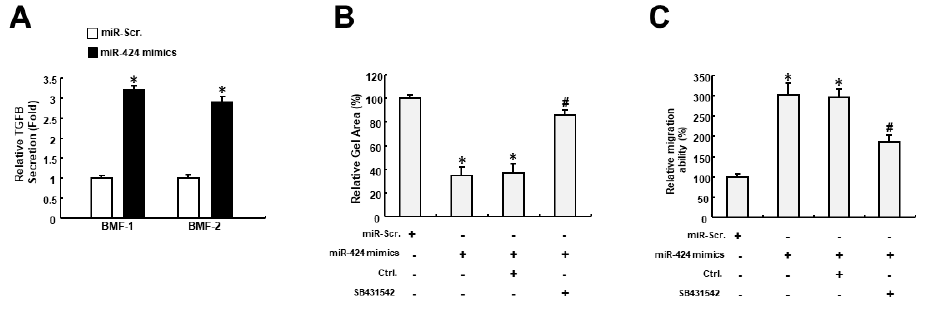
Figure 5. The miR-424-induced myofibroblast features may result from the activation of the TGF- β pathway. ( A ) The secretion of TGF- β was increased in BMFs treated with miR-424 mimics. ( B ) Collagen gel contractility was increased in miR-424 mimics-receiving cells, while inhibition of the TGF- β pathway using SB431542 prevented it. ( C ) The increased migration ability elicited by miR-424 mimics was reduced by SB431542. * p < 0.05 compared to miR-Scr. group; # p < 0.05 compared to miR-424 mimics+ Ctrl. group.